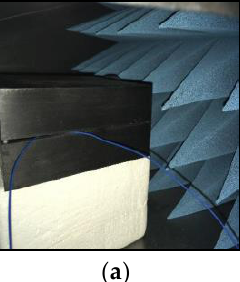
Figure 3. ( a ) The EUT chamber where the cells were placed; ( b ) NIH/3T3 mouse fibroblast cell line inside the EUT